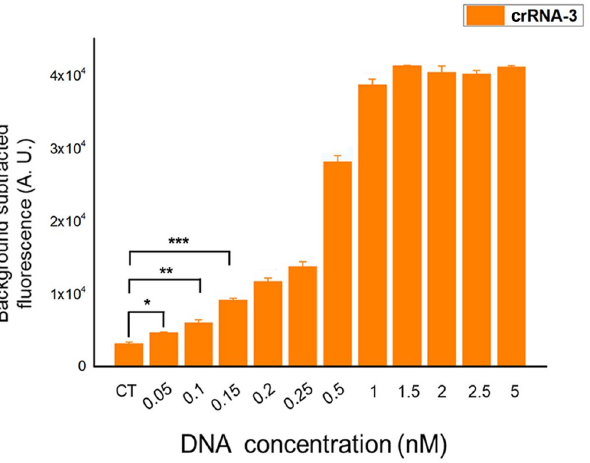
Fig 3. Sensitivity of the Cas12a-based ASFV fluorescence reporting system. Cas12a assay can detect as low as 0.05 nM of PCR products. n = three technical replicates, bars represent mean ± SD, ��� p < 0.001, �� p < 0.01, � p < 0.05.